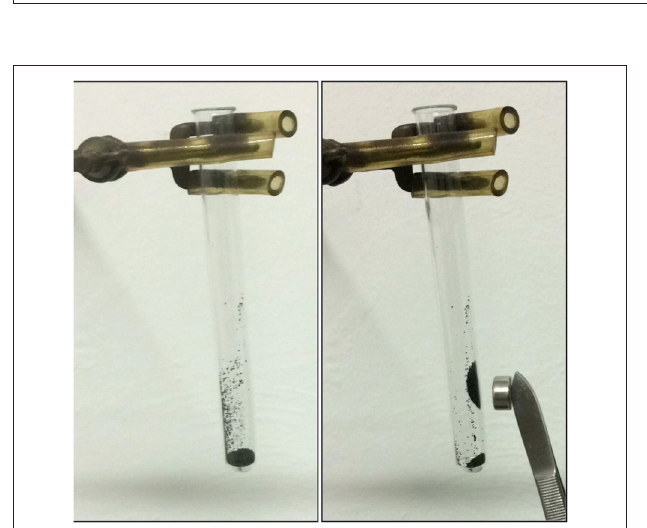
FIGURE 8 | Pictures showing the macroscopic magnetic properties of the Fe 3 O 4 -based carbon microspheres.